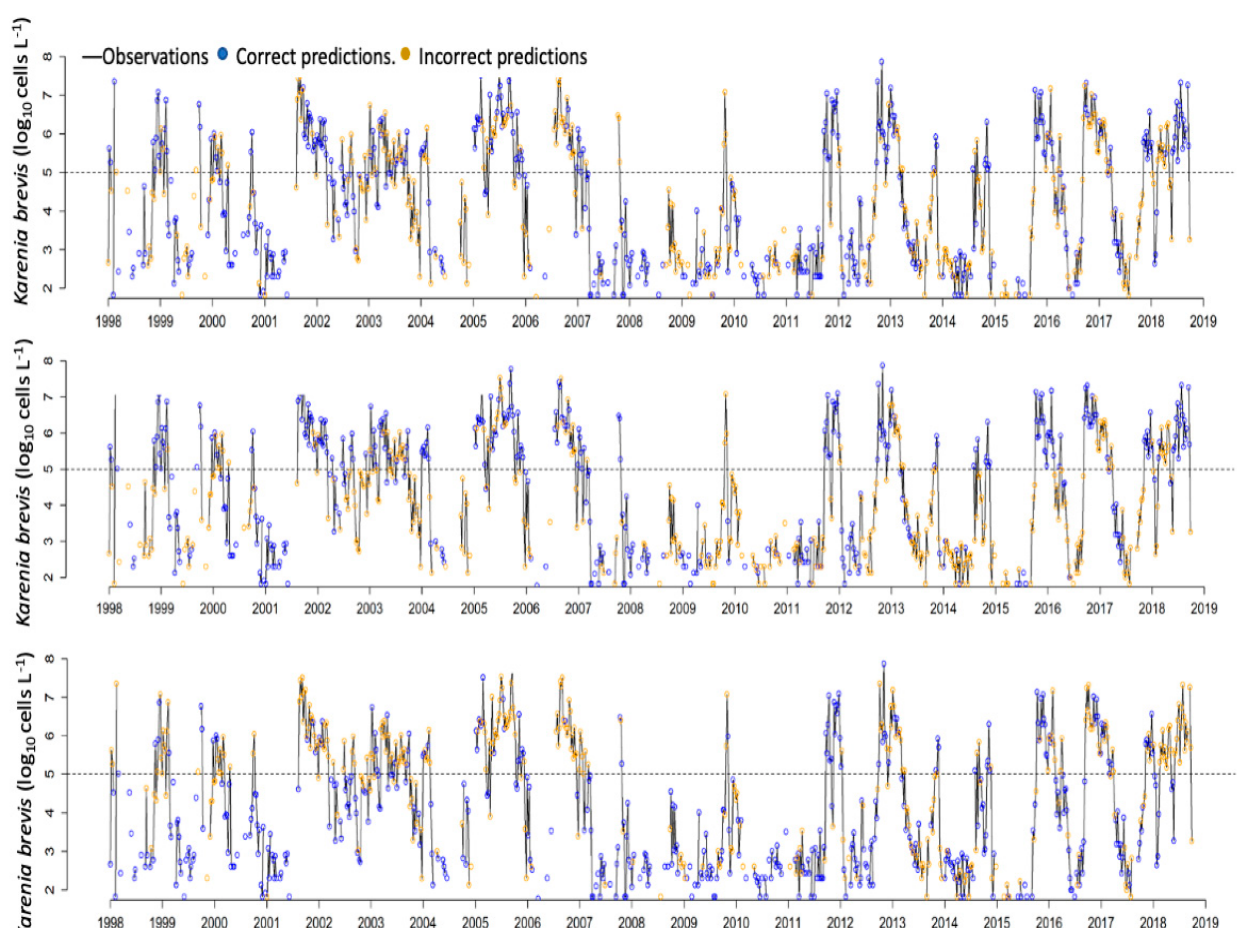
Figure 4. Comparative model outputs of the observed (black line) and predicted (blue and orange dots) area-averaged K. brevis concentrations from 1998 to 2018 for the Relevance Vector Machine (top panel), Naïve Bayes (middle panel), and Artificial Neural Network (bottom panel). Cell counts above 5 (log 10 cells L − 1 ; dashed line) are herein considered bloom conditions.